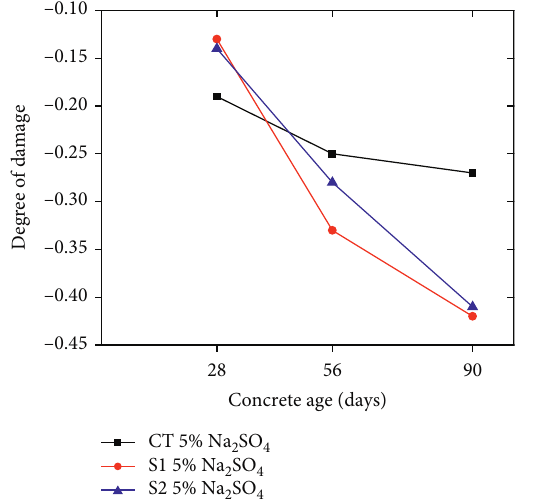
Figure 10: Degree of damage of CT, S1, and S2 immersed in the sulphate